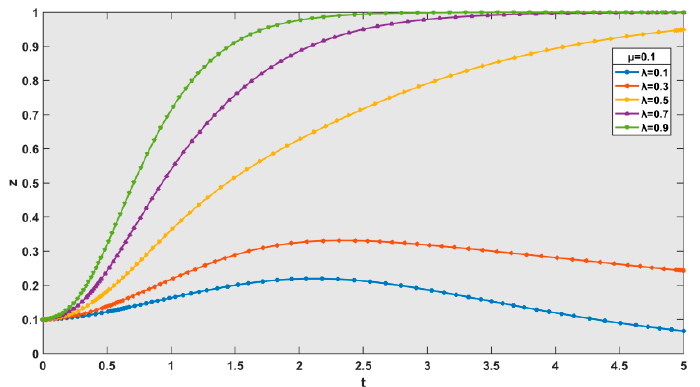
evolution trajectory.